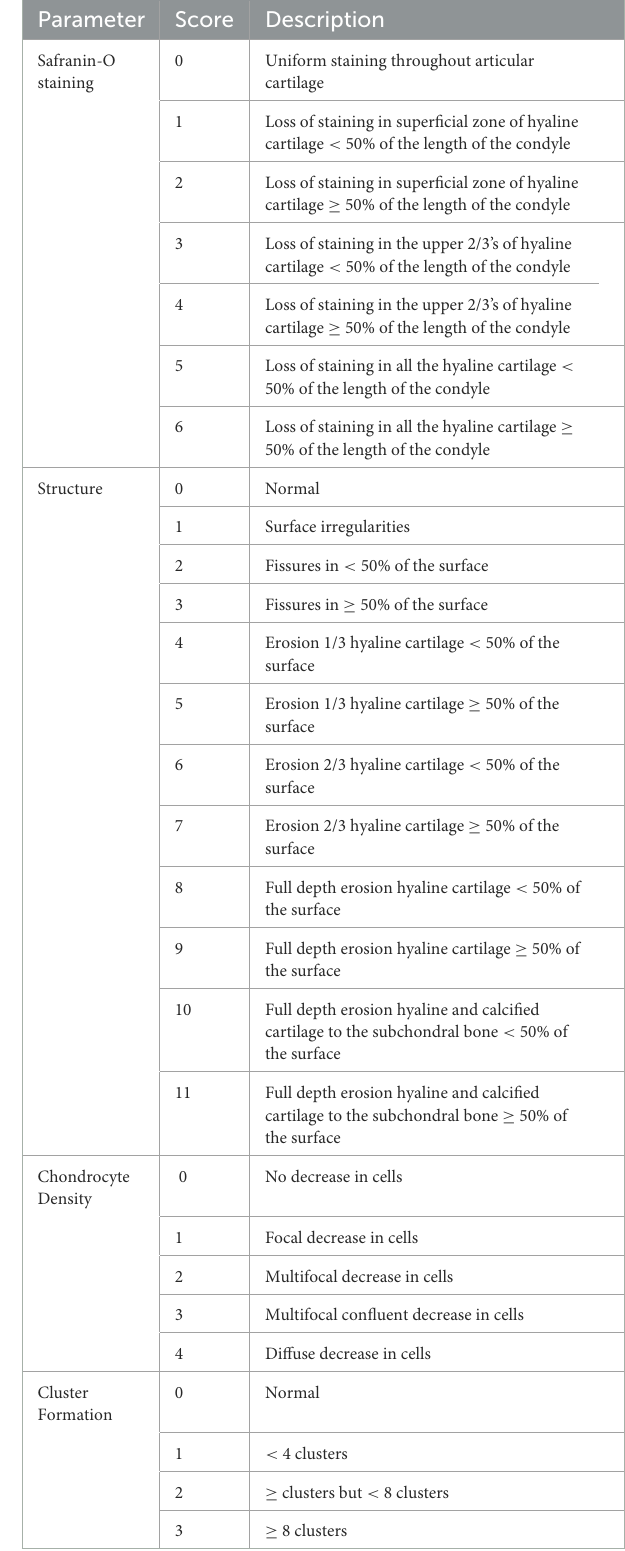
TABLE 1 OARSI Histological assessment of articular cartilage changes in rabbit model of